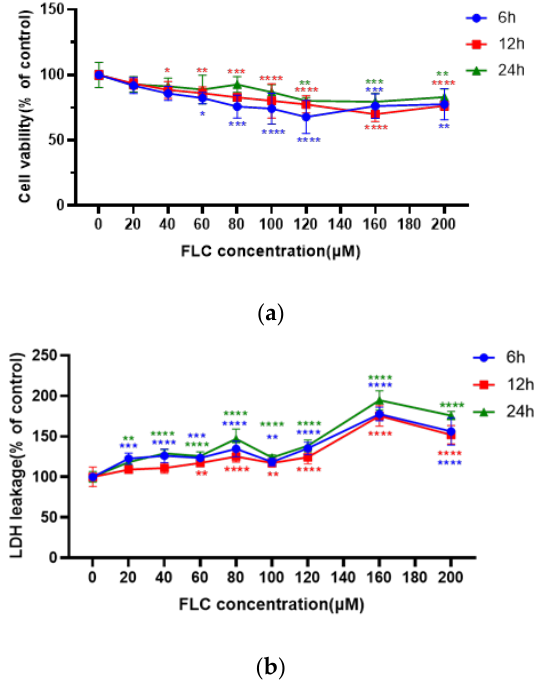
Figure 1. FLC inhibited cell viability and induced cytotoxicity in TM4 cells. TM4 cells were